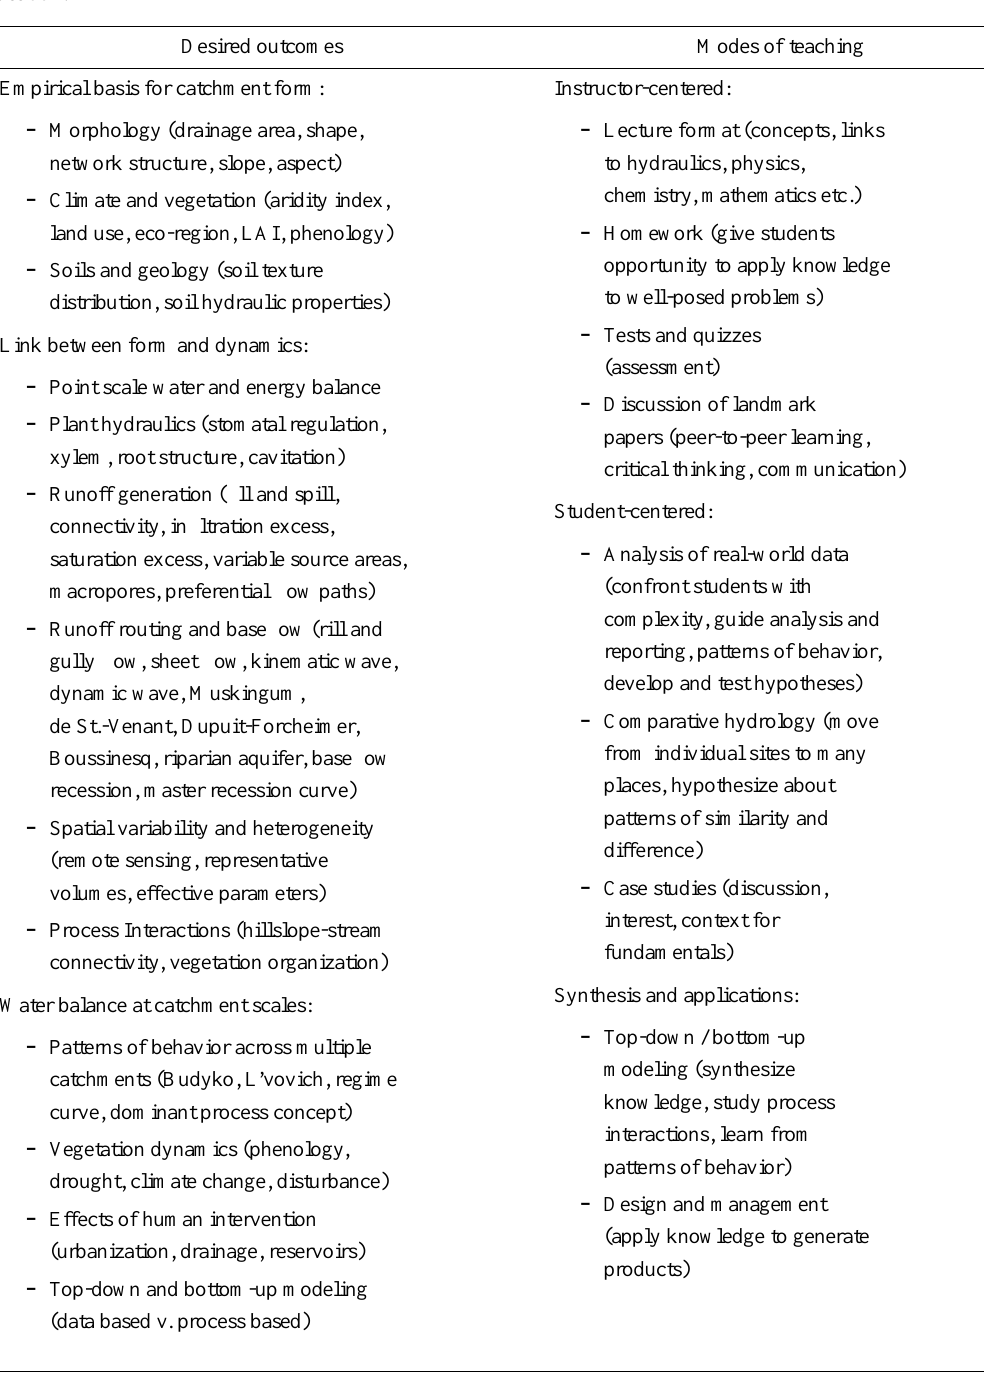
Table 2. Summary curriculum adopted by Troch and Sivapalan uniting deductive and inductive teaching methods for graduate catchment hydrology